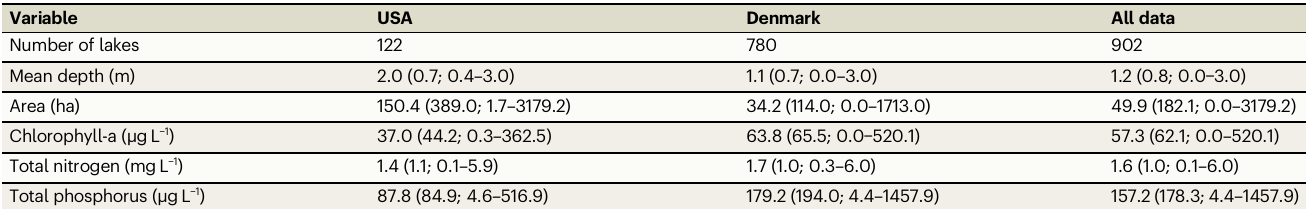
Table 1 | Number of lakes, means (1 SD; minimum-maximum) of the contemporary data from the USA, Denmark and the full dataset Variable USA